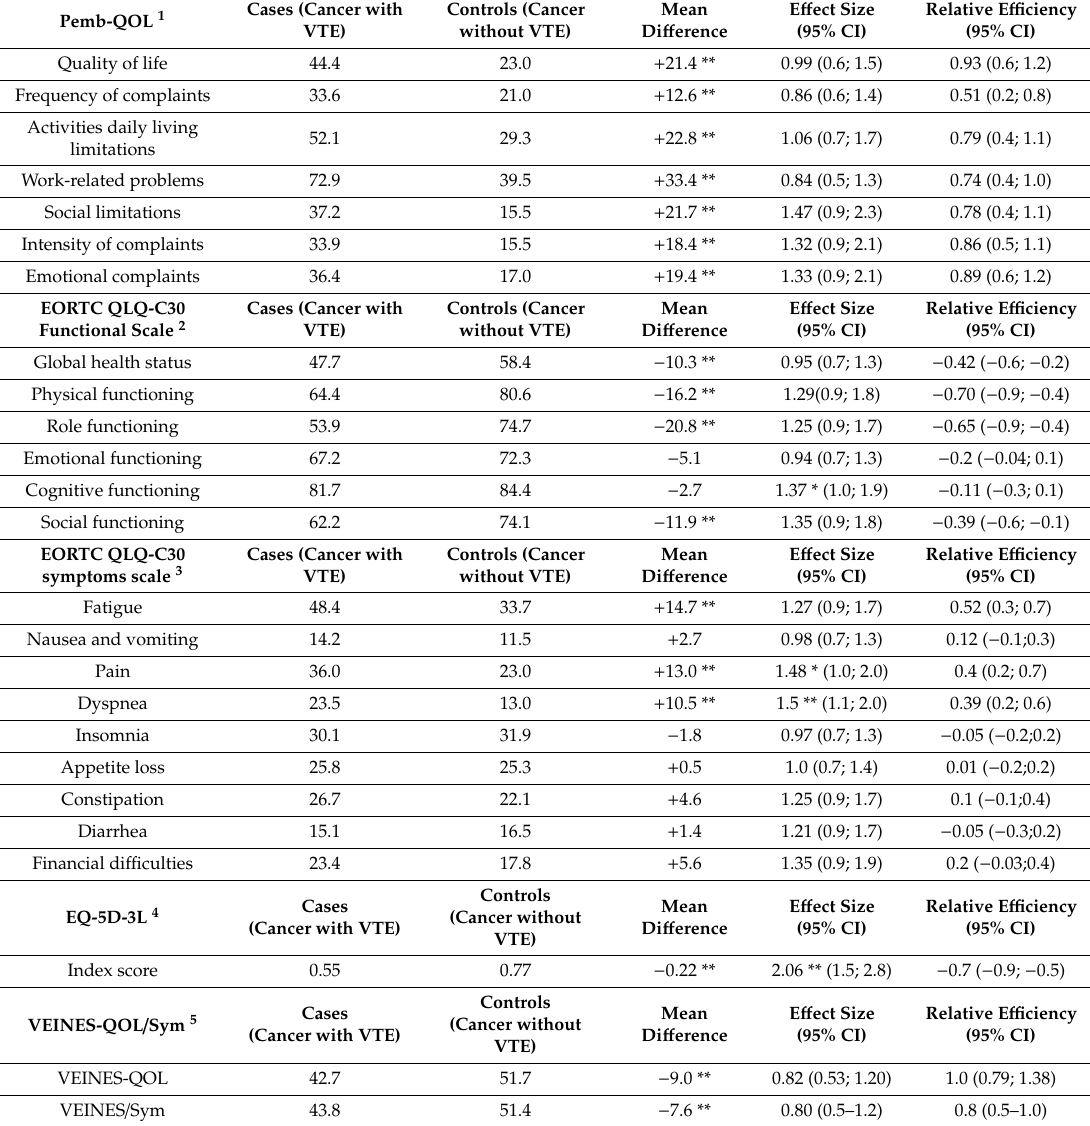
Table 2. Di ff erences in the Pemb-QOL, EORTC QLQ-C30 functional and symptoms scales, EQ-5D-3L, and VEINES scale scores between cases and